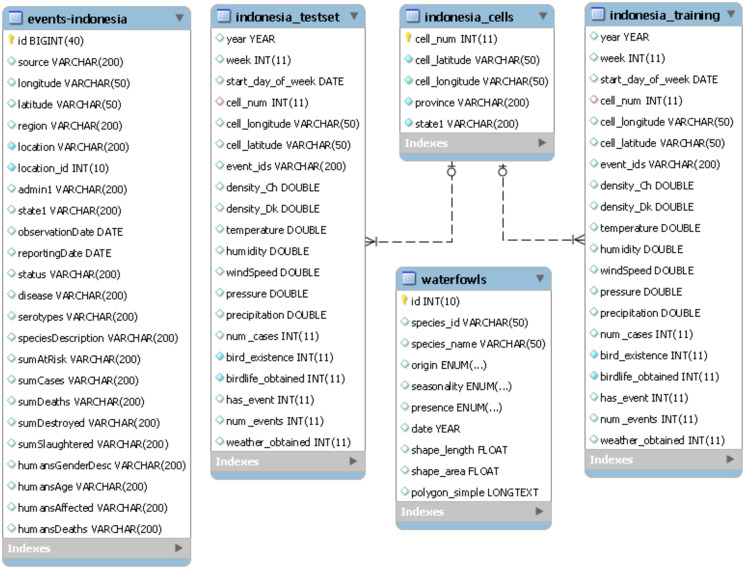
Database schematic.